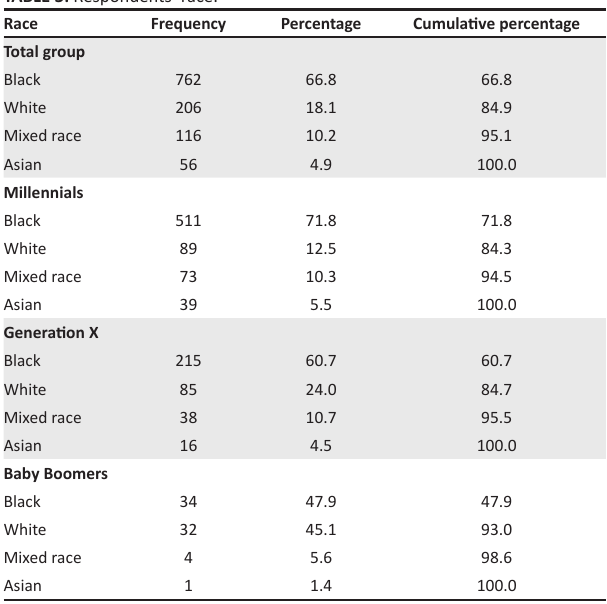
TABLE 3: Respondents’ race.